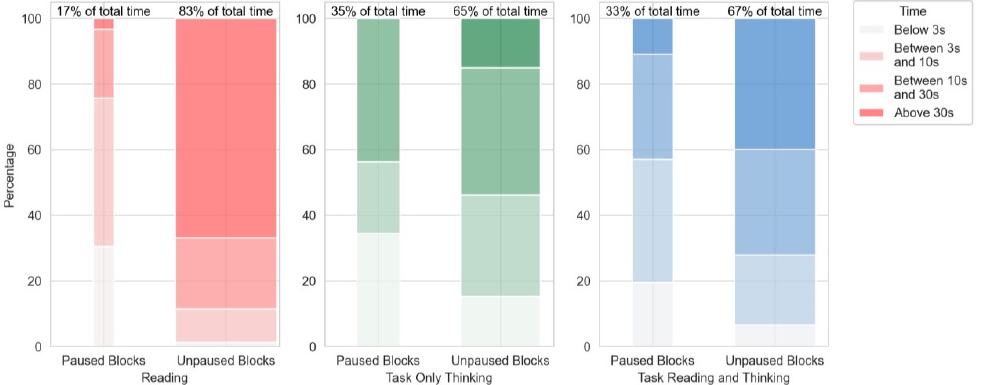
Figure 9. Block during which translations were paused or unpaused separated by reading and task. The task is split into “only thinking” and “thinking and reading”. The data uses the mean of the distributions of participants, so that the length of a run does not increase its weight; each participant had the same